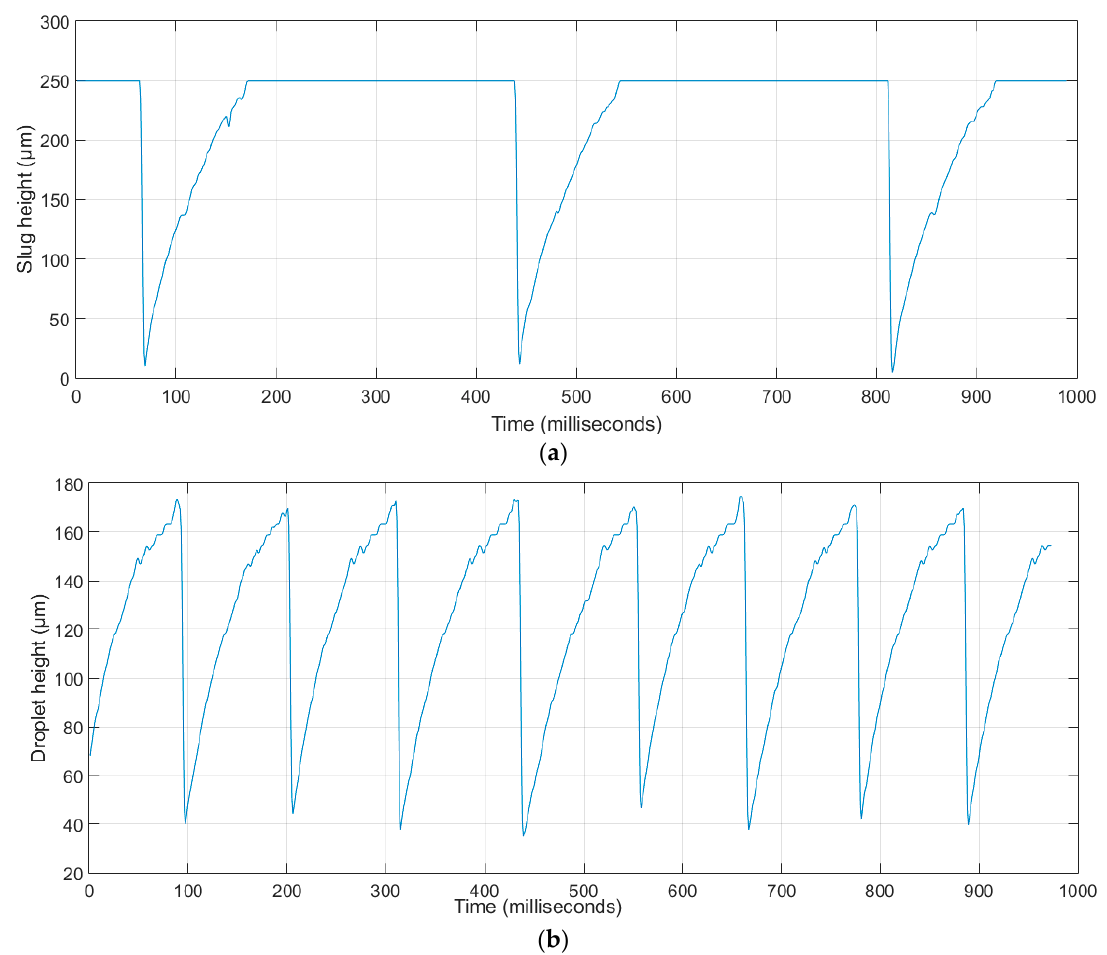
Figure 17. Height: ( a ) slug flow; ( b ) droplet flow.